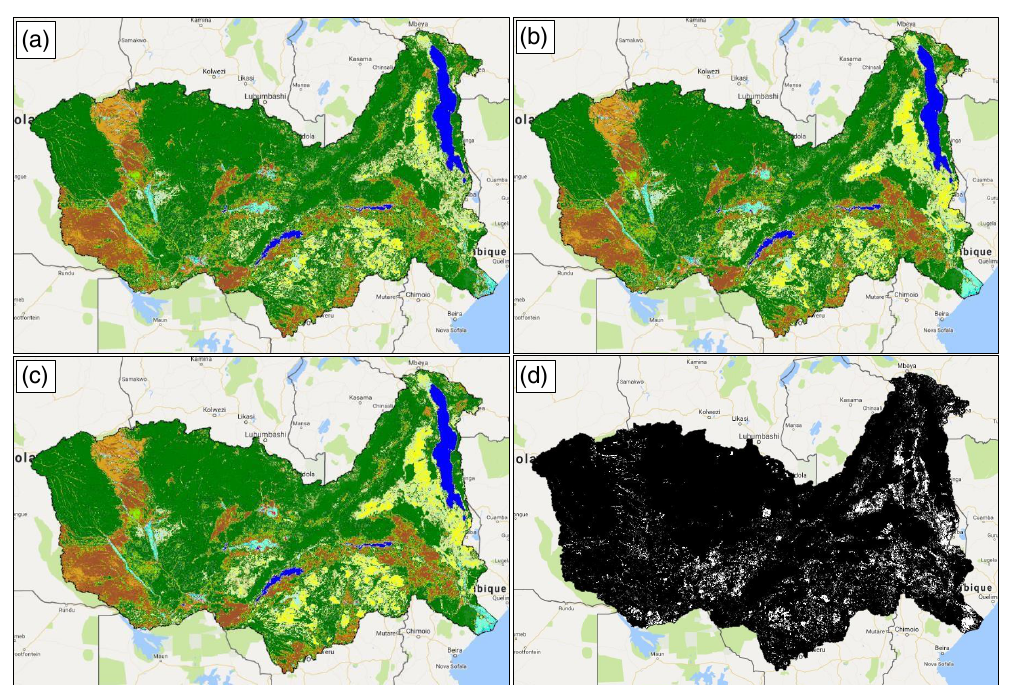
Figure 4. Zambezi land cover maps for 1992 and 2015, and land cover difference map showing areas of land cover change for this period ( a Zambezi Land Cover 1992; b Zambezi land cover 2004; c Zambezi land cover 2015; d Zambezi squared difference